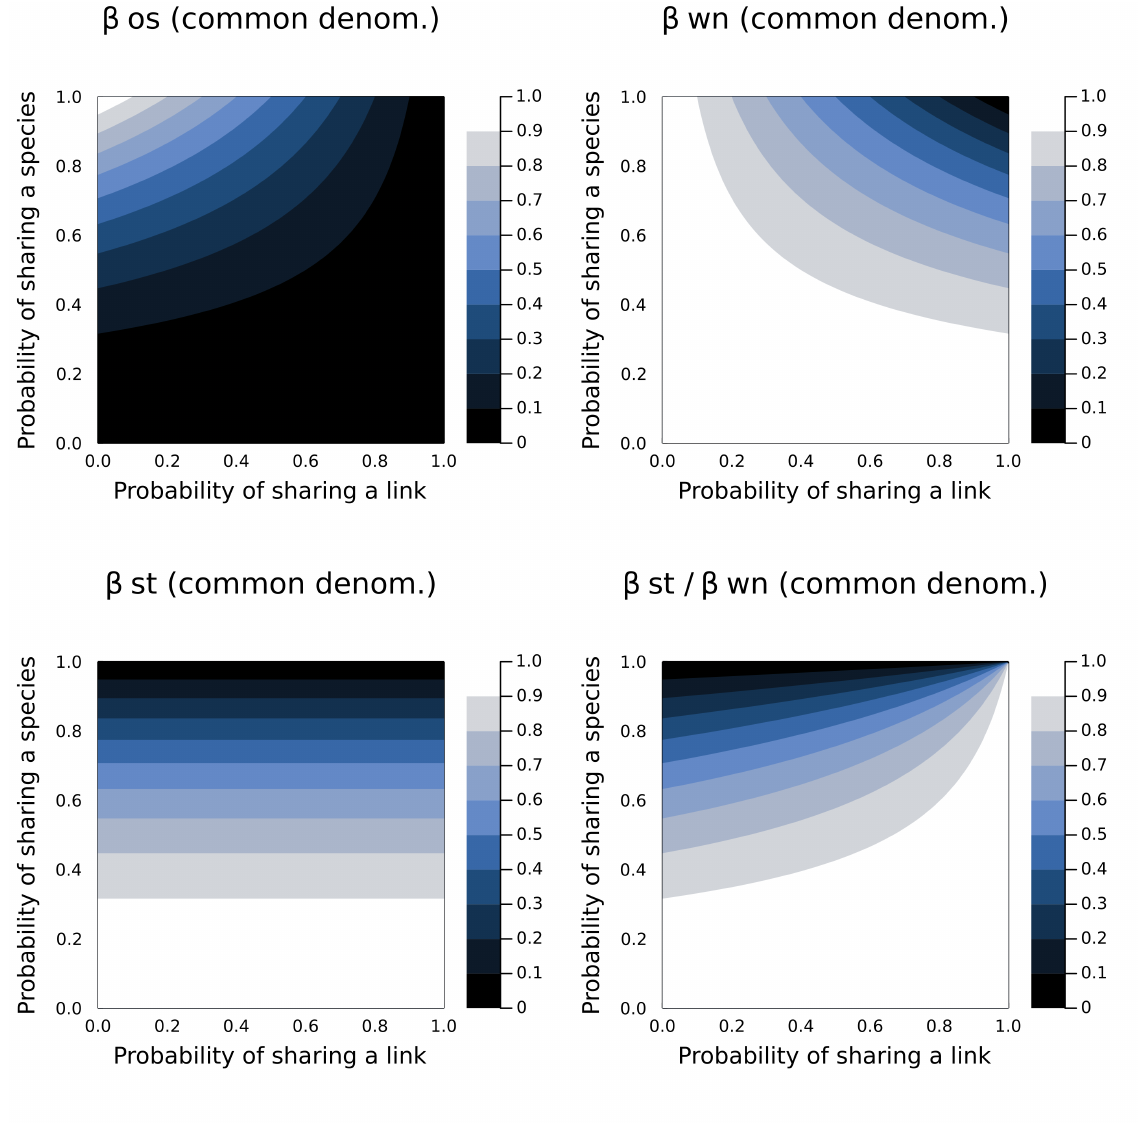
Figure 4 – Reproduction of fig. 2 with the alternative denominators proposed by Fründ